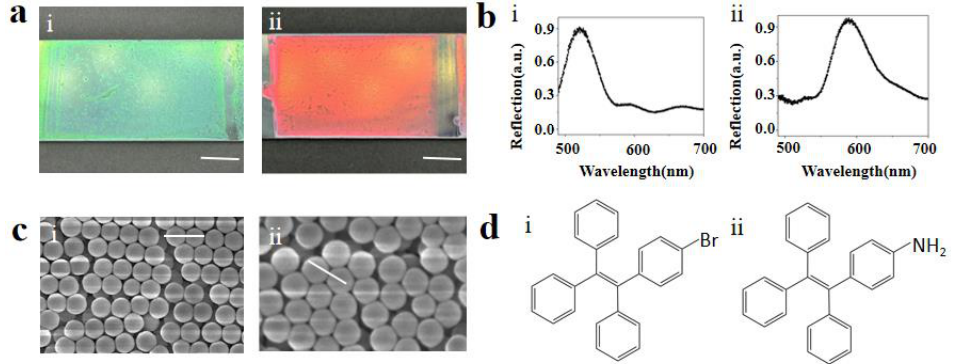
Figure 2. ( a ) PCs of different colors are scraped on flat glass. ( i ) green ( ii ) red, scale bar: 1 cm. ( b ) Reflectance spectra of the corresponding PCs. ( i ) 520 nm ( ii ) 590 nm. ( c ) Scanning electron microscopy images of the PCs. ( i ) Green PCs, scale bar: 500 nm ( ii ) red PCs, scale bar: 500 nm. ( d ) Chemical structure of different AIEgens. ( i ) AIE10 ( ii ) AIE25.